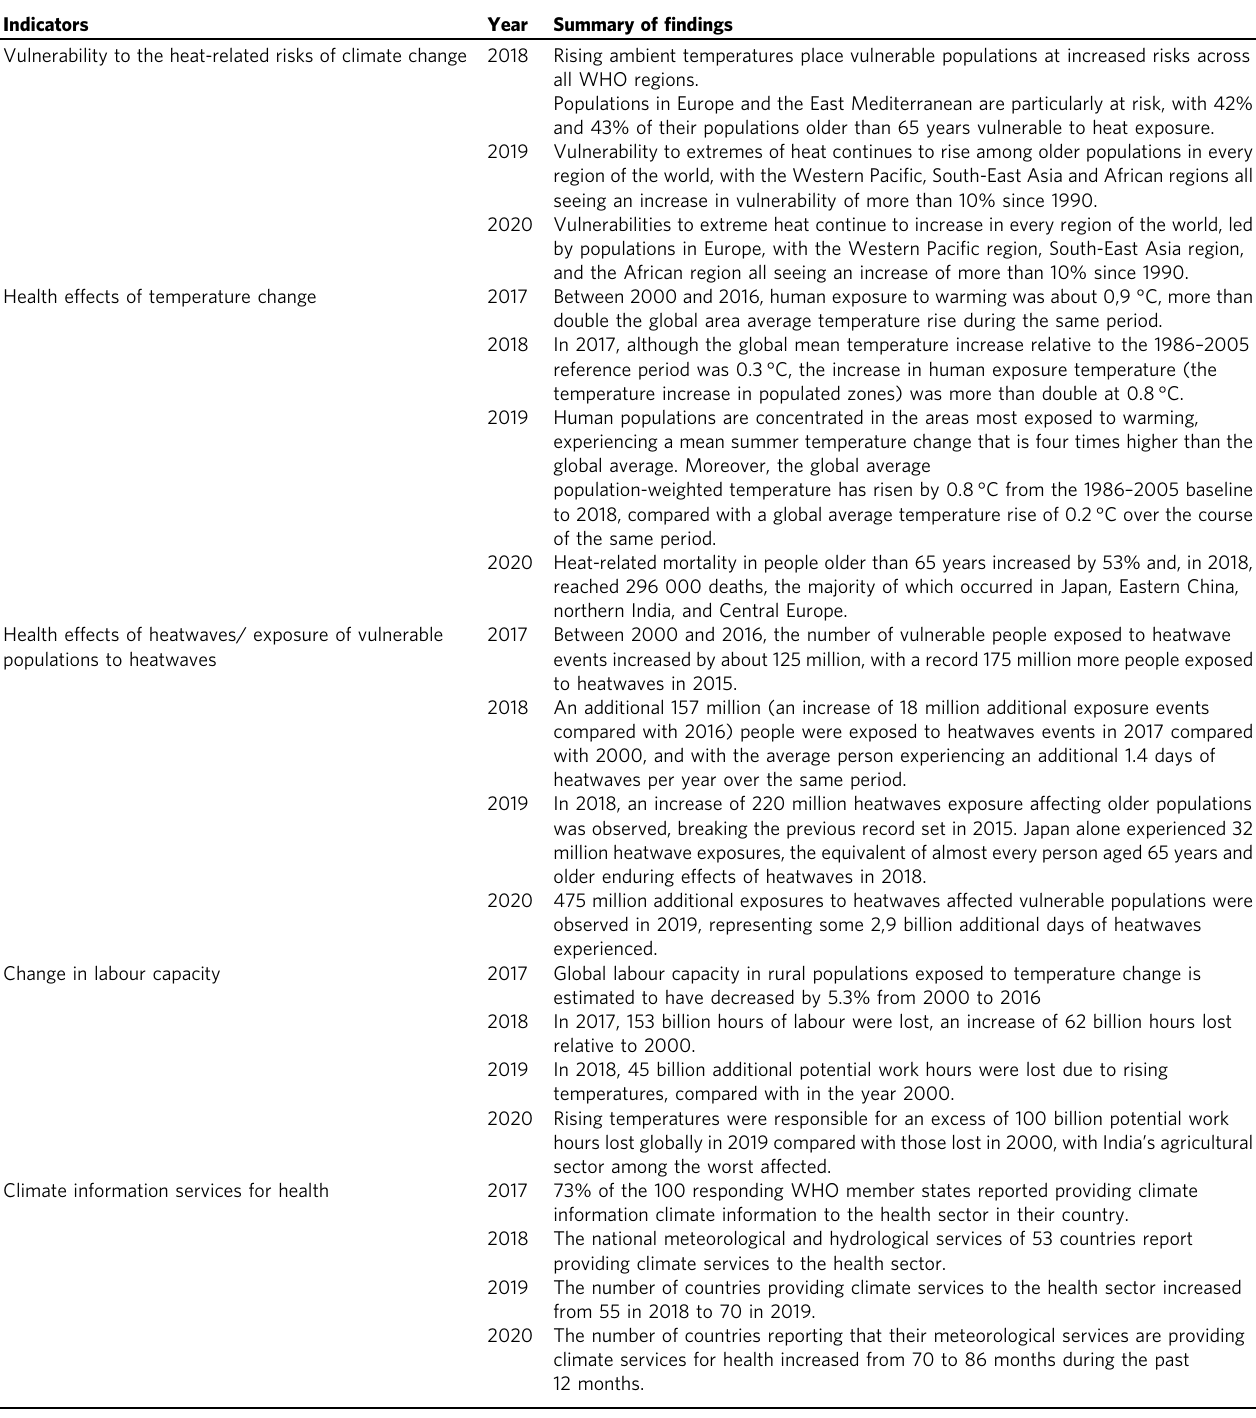
Table 1 Summary of key fi ndings on heat-health and adaptation indicators from Lancet Countdown Reports.